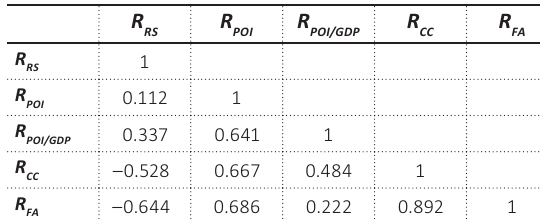
Table 5. Correlation matrix of indicators of the level of fiscal policy decentralization by influence on the formation of local budget revenues